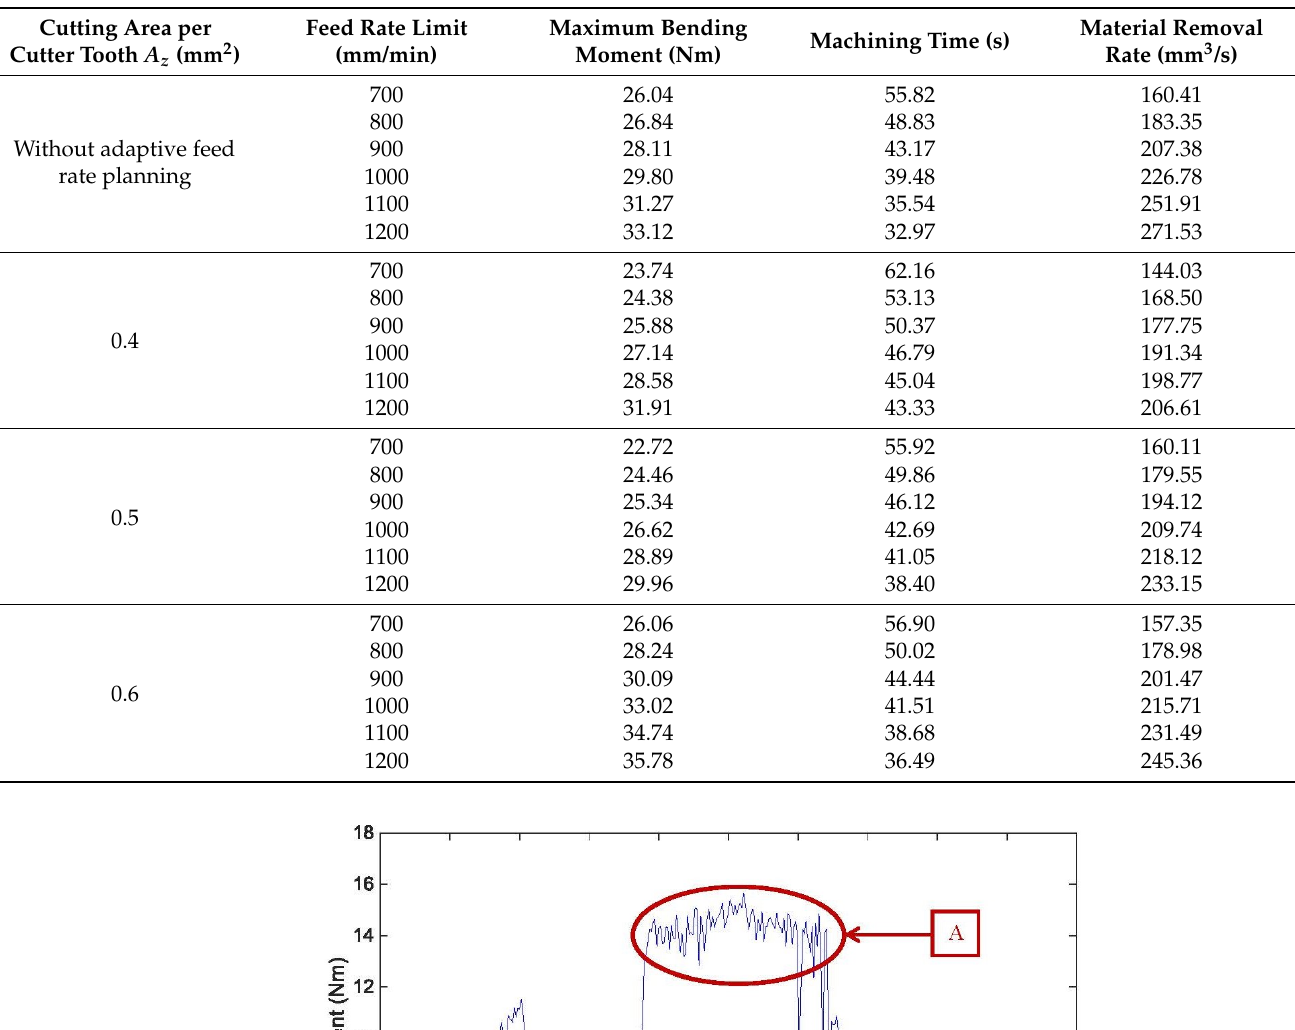
Table 3. Experimental results without and with adaptive feed rate planning.